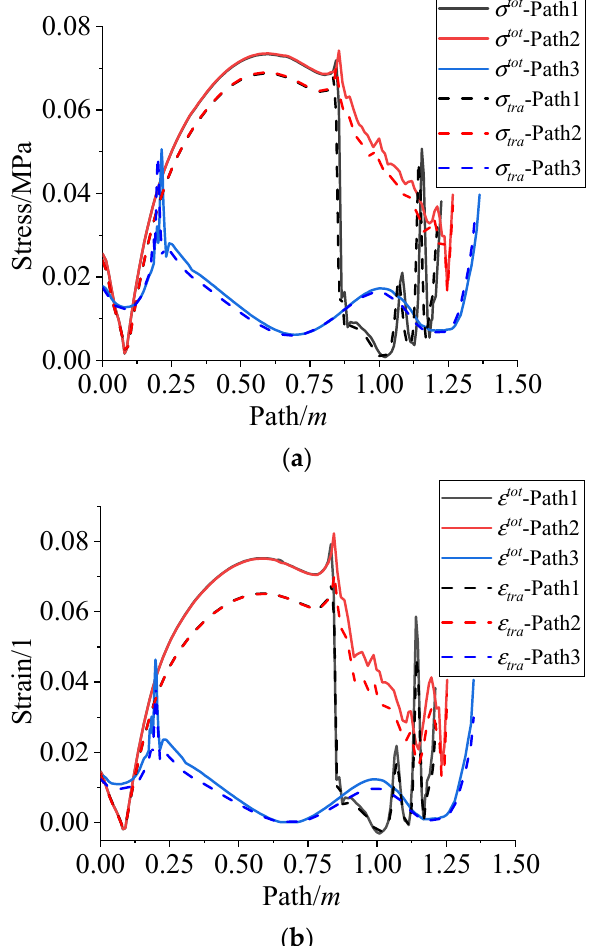
Figure 16. Comparison between the results in this paper and the traditional methods. ( a ) Comparison of residual stress varies along path 1~3. ( b ) Comparison of residual strain varies along path 1~3.